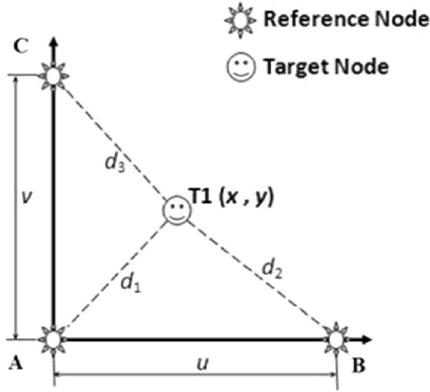
Fig. 2 Tags and readers arrangement